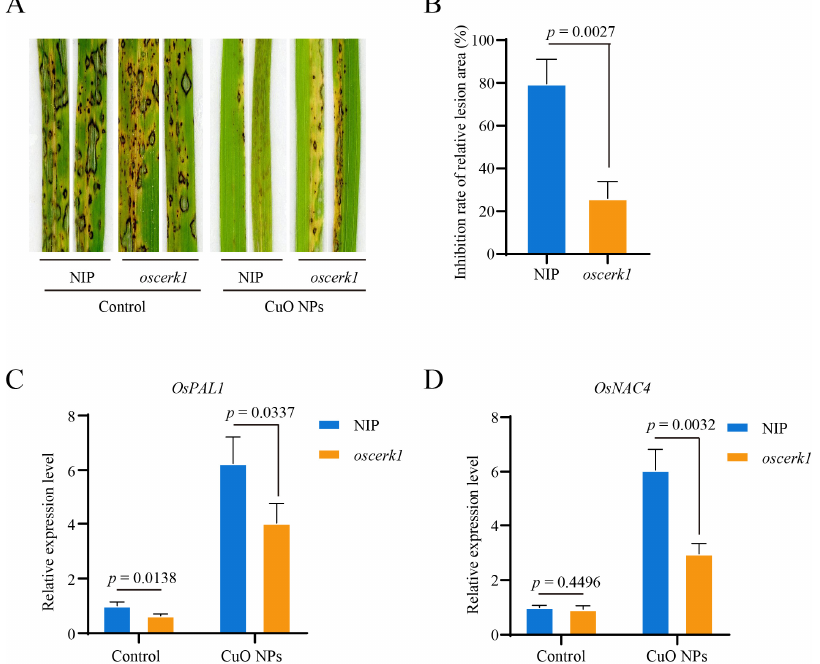
Figure 5. OsCERK1 contributes to basal resistance against M. oryzae under CuO NPs stress condition. Disease symptoms ( A ), the relative lesion areas ( B ), relative expression levels of PR genes OsPAL1 ( C ) and OsNAC4 ( D ) of the oscerk1 mutant and its wild-type Nipponbare (NIP) inoculated with M. oryzae after treated with CuO NPs for 14 days. The relative lesion area was calculated by ImageJ. The relative inhibition rate of the relative lesion area was calculated based on the formula: inhibition rate (%) = [the relative lesion area (control) − the relative lesion area (CuO NPs)] / the relative lesion area (control) × 100%. The relative transcript abundances were calculated using the 2 −ΔΔ C T method with Ubiquitin gene as the internal control. The bars are shown as means ± SD of three replications. The student’s t -test was used to analyze the data and generate p value.